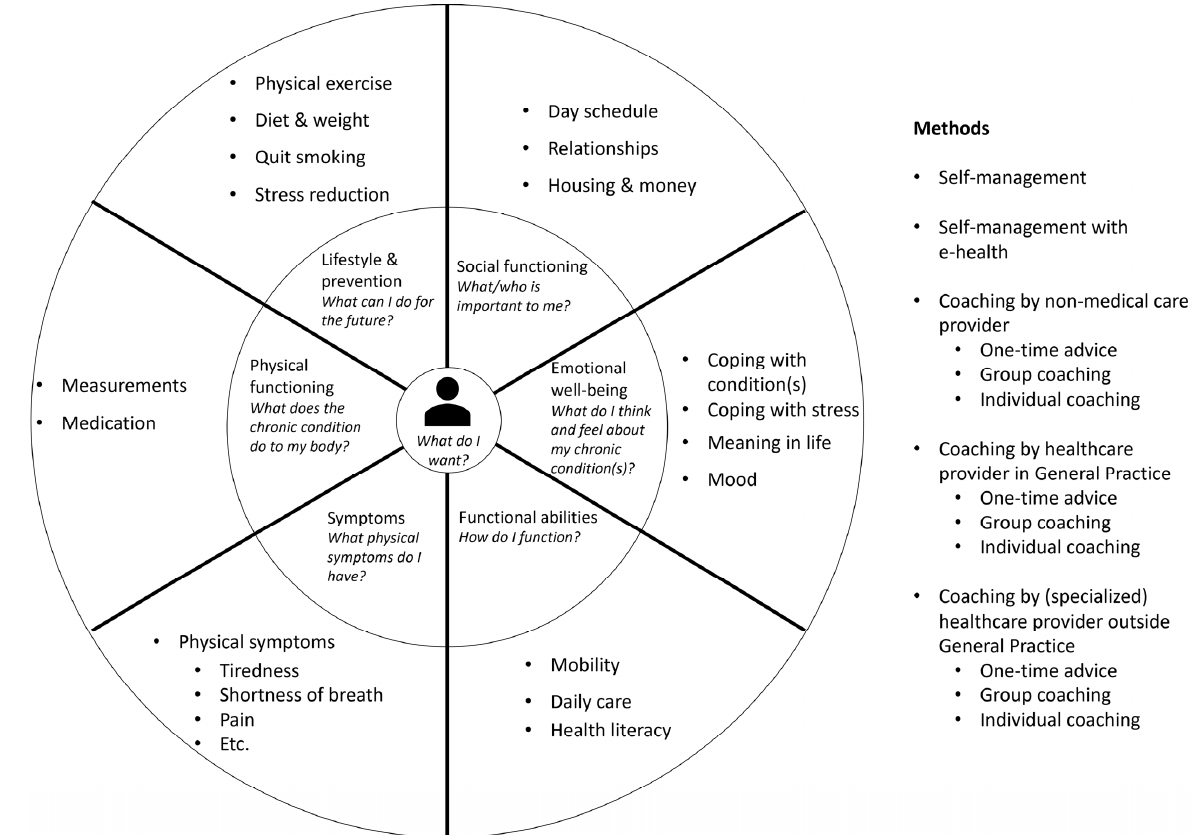
Figure 1. Person-centred and integrated care programme for people with chronic diseases.